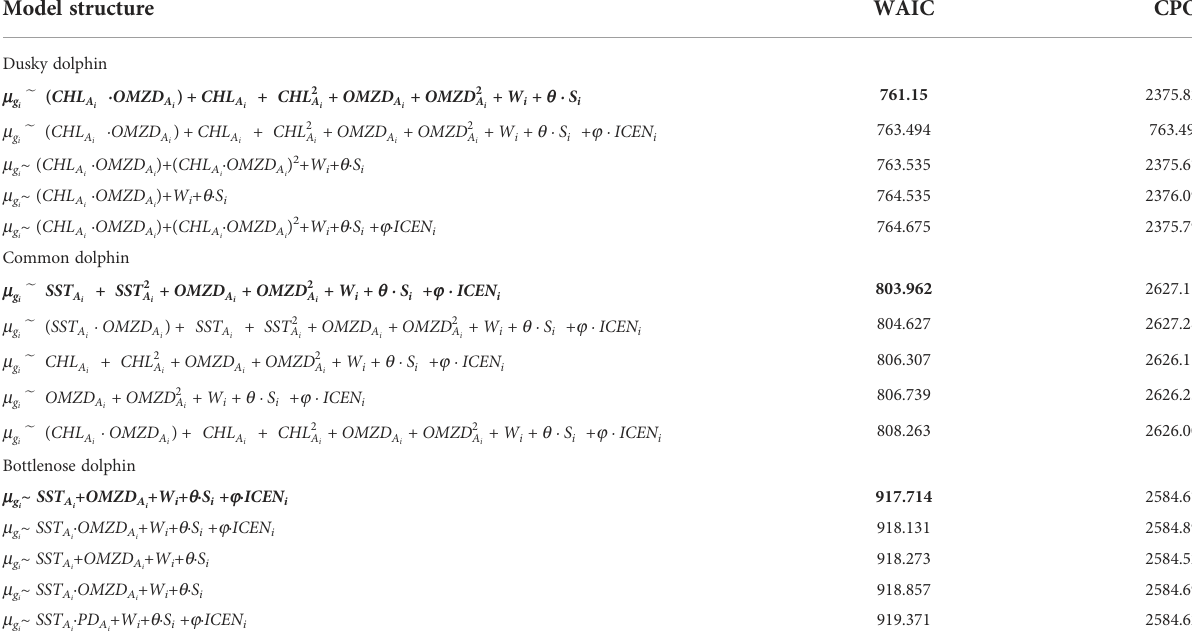
TABLE 1 Comparison of the best fi ve model structures for predicting the habitat suitability of dusky, common, and bottlenose dolphins in northern Humboldt Current System. Model